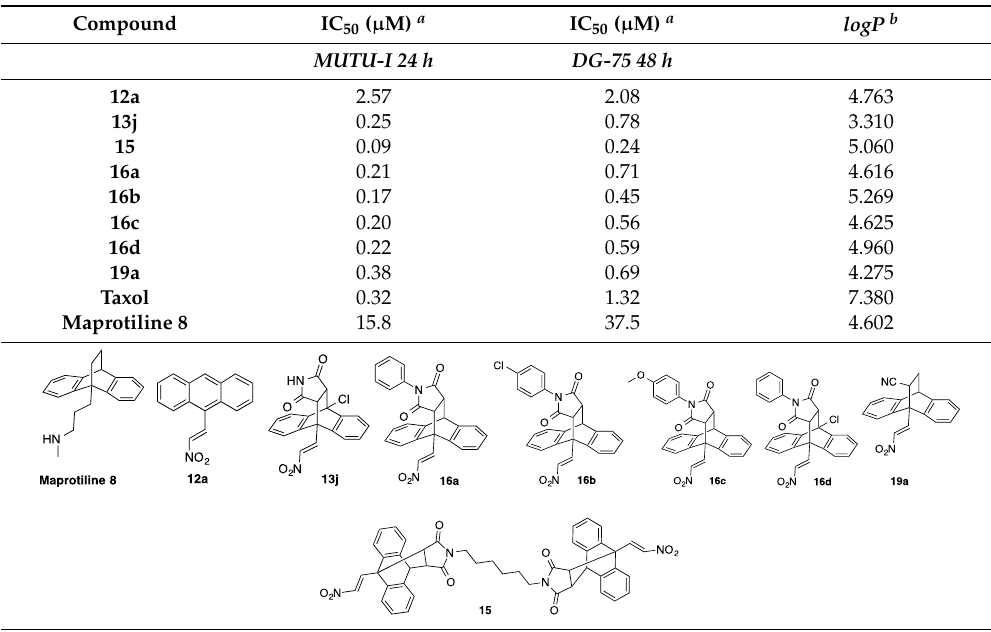
Table 11. IC 50 values of selected compounds 12a , 13j , 15 , 16a – d , 19a in BL cell lines DG-75 and MUTU-I Burkitt lymphoma cell lines.